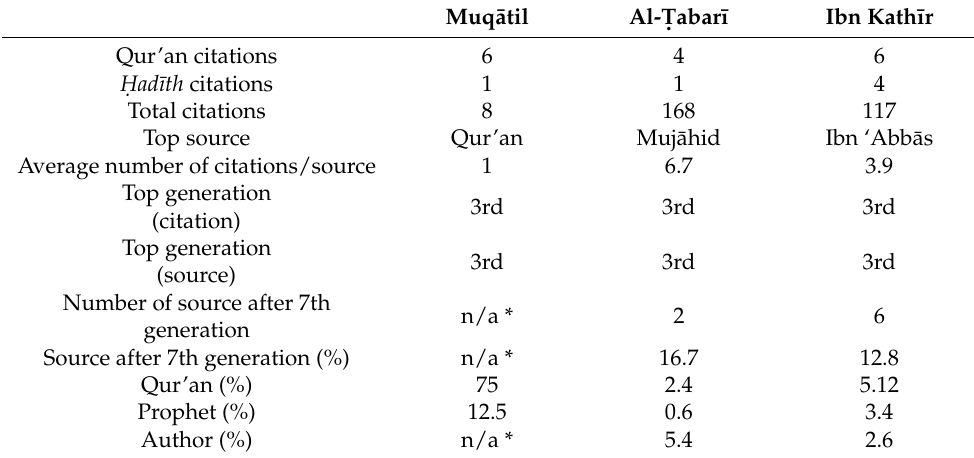
Table 1. Sources of Qur’anic